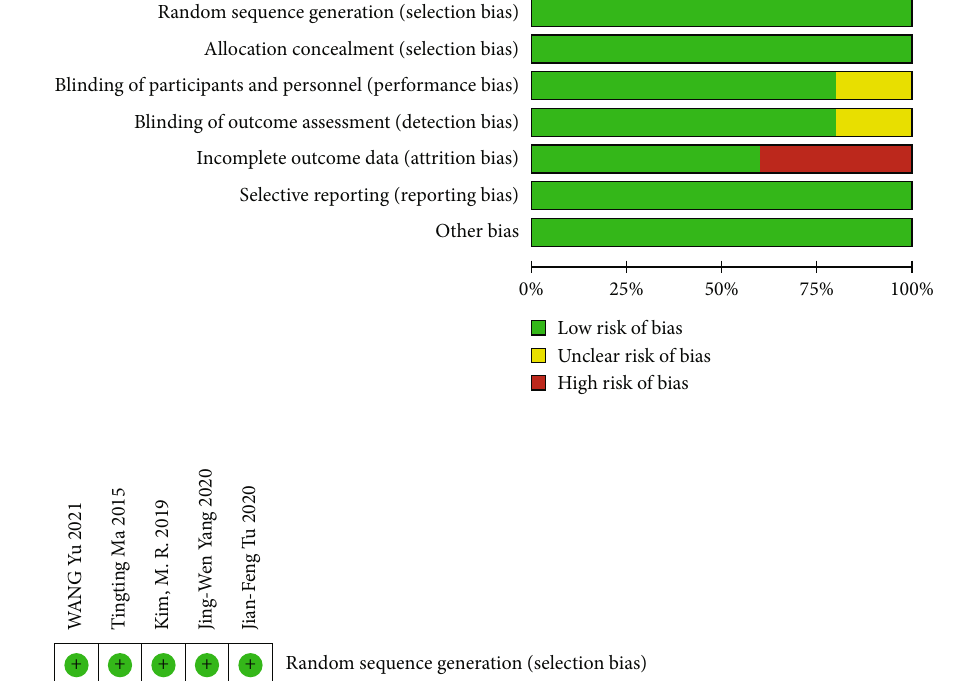
Figure 2: Risk of bias.